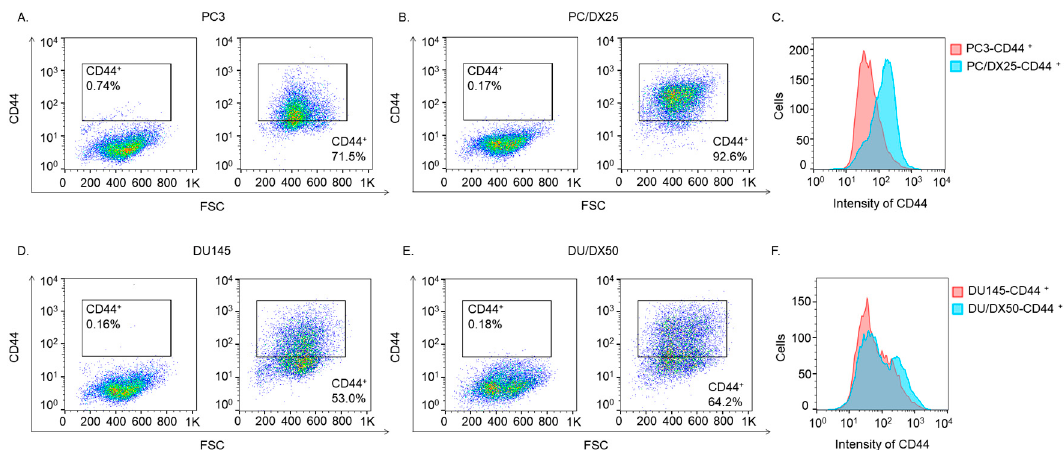
Figure 2. FACS analysis of CD44 protein expression in PC-3, PC/DX25, DU-145, DU/DX50 cells. Fluorescence activated cell sorter (FACS) analysis was used to analyze the CD44+ and CD44 − populations in PC-3 ( A ), PC/DX25 ( B ) cells using PE filter ( C ), as well as to analyze the CD44+ and CD44 − populations in DU-145 ( D ), DU/DX50 ( E ) cells using PE filter ( F ).